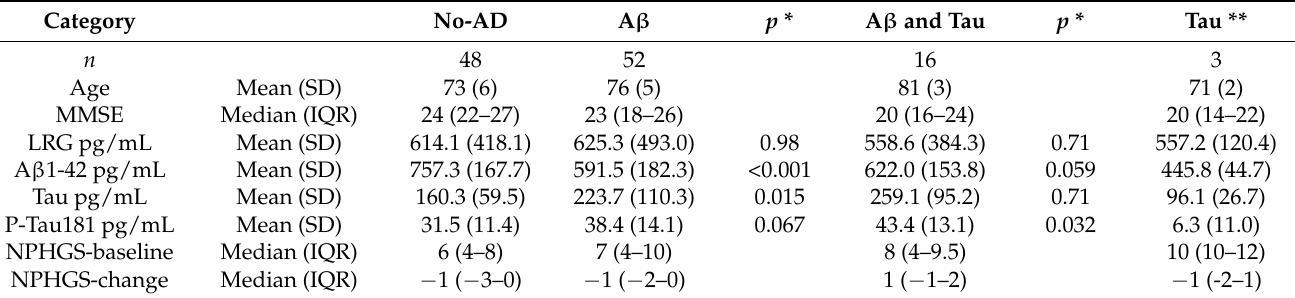
Table 3. Cerebrospinal fluid (CSF) biomarker levels according to brain biopsy Alzheimer’s disease (AD)-related pathology in iNPH